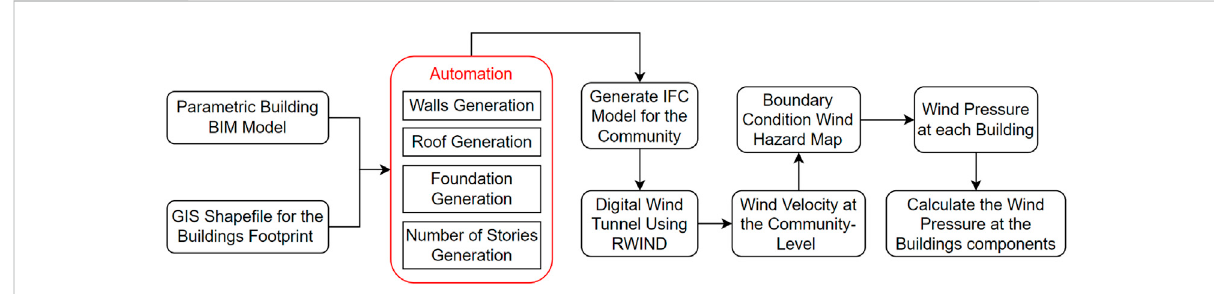
FIGURE 1 A schematic fl owchart for the developed approach to integrate BIM and GIS models for wind damage analysis.